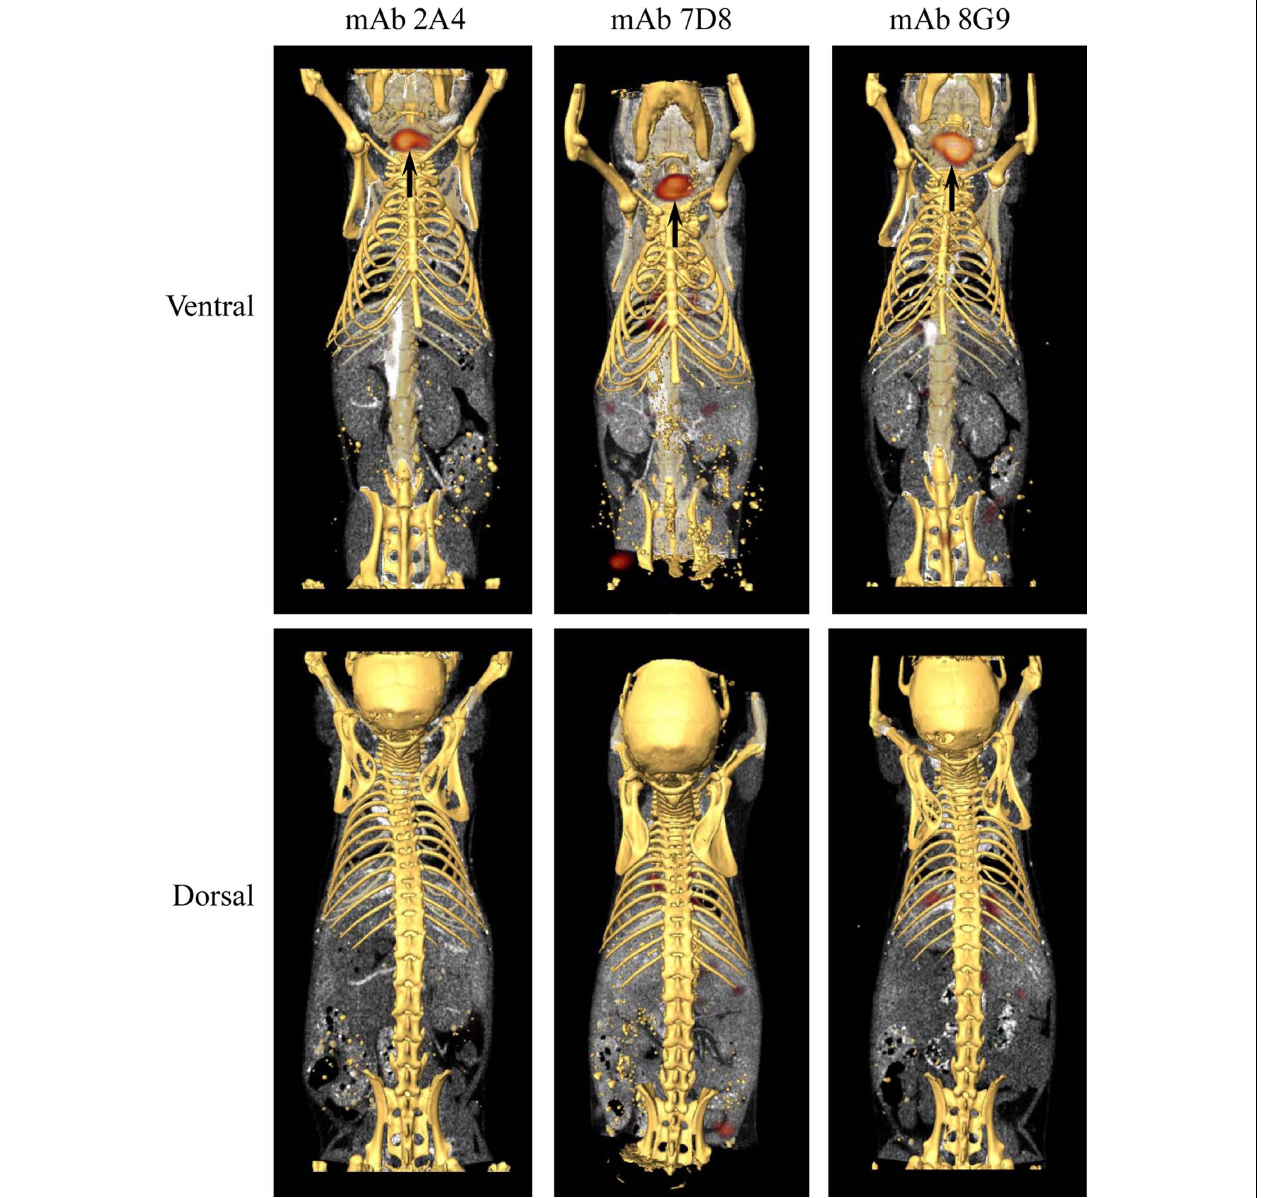
FIGURE 6 | Biodistribution of mAbs in healthy, amyloid-free mice. SPECT/CT images obtained 48h after animals were injected with ∼ 250 μ Ci of 125 I-labeled mAbs 2A4, 7D8, and 8G9. No accumulation of the radiotracers was detected in healthy organs. Arrows indicate the presence in the thyroid of free iodide liberated during